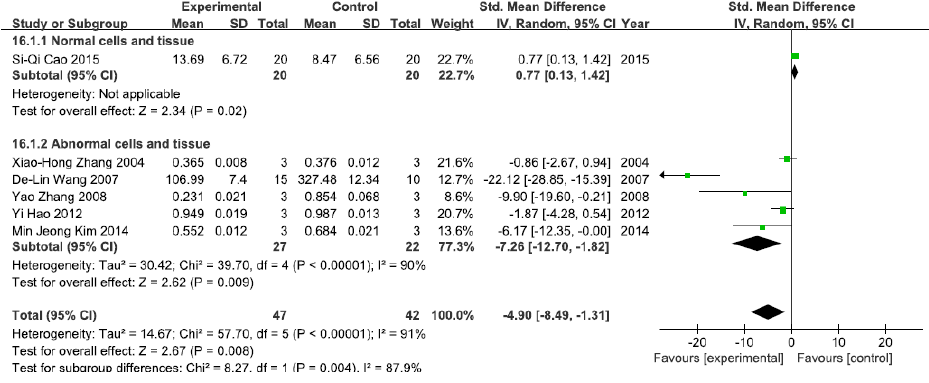
Figure 4. Effects of arsenic on nuclear transcription factor kappa B p65(NF ‐κ Bp65). Forest plot showing the impact of arsenic treatment on NF ‐κ Bp65 compared with controls. Abbreviations: SMD = standardized mean difference, IV = independent variable, 95% CI = 95% confidence interval.